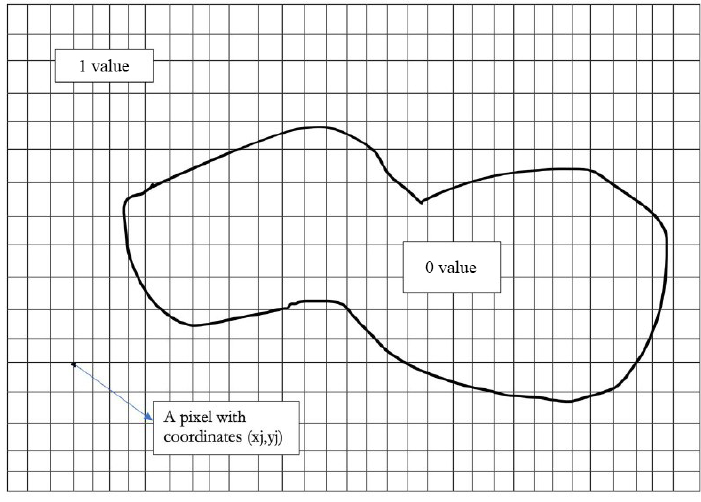
Figure 1. Area to cover in a grid.